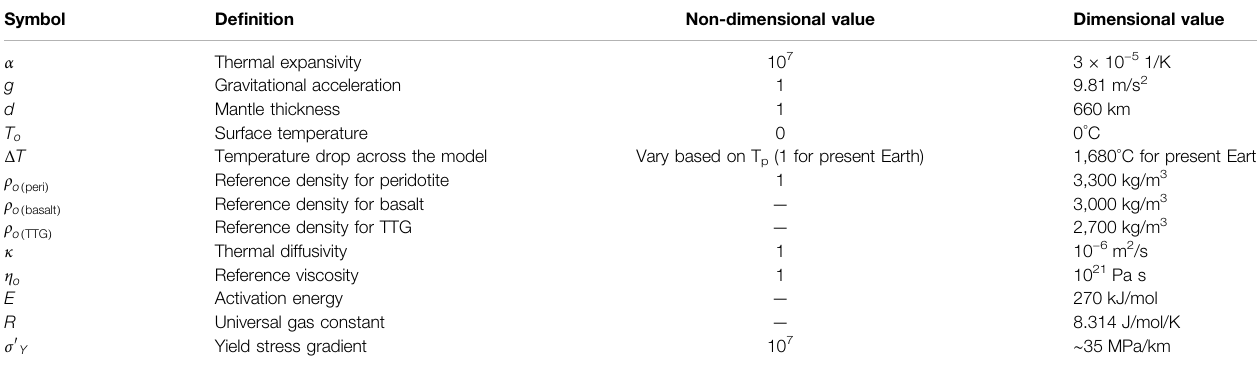
TABLE 1 | Physical properties used in numerical modeling.